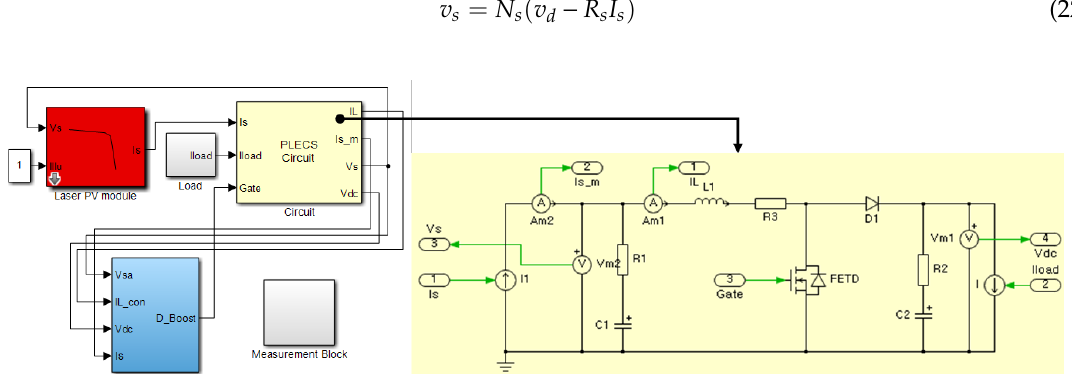
Figure 14. Simulation model using Matlab / Simulink.